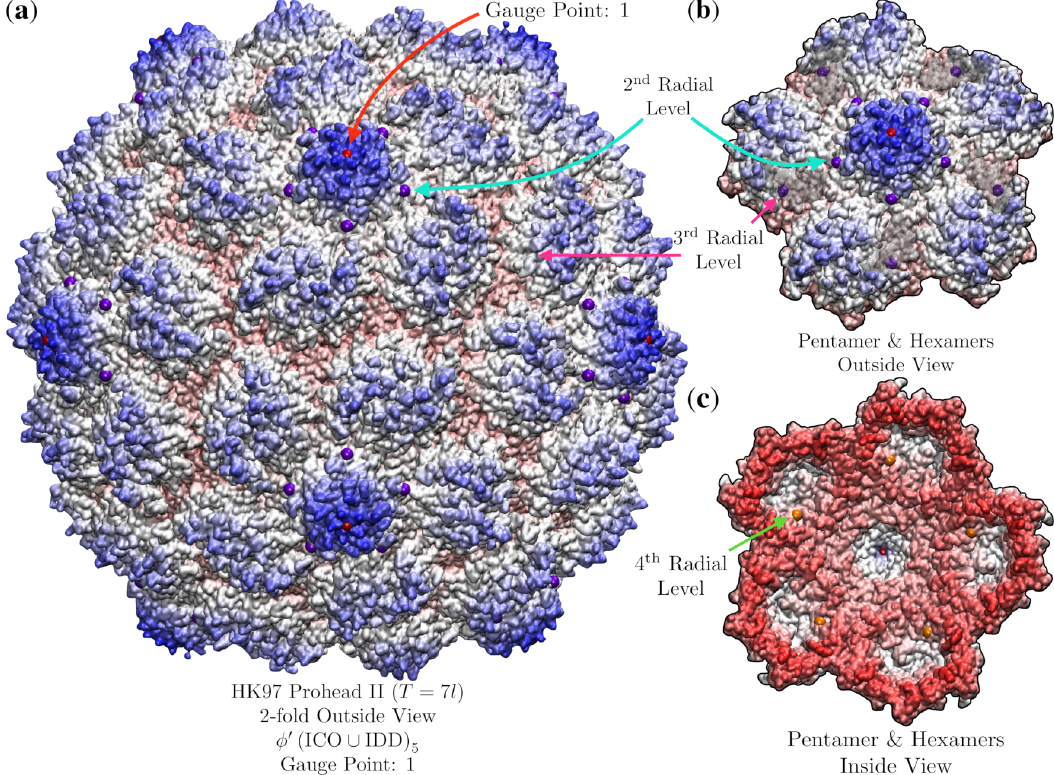
Figure 20. Point arrays may predict a loss of local symmetry of hexameric subunits for Bacteriophage HK97 Prohead II ( T = 7 l , 3e8k [37]), as the hexamer subunits have different geometric restrictions at non-equivalent locations. ( a ) This capsid is best fitted by φ (cid:48) ( ICO ∪ IDD ) 5 with an RMSD of 1.8 Å. The pentamer protrudes at Gauge Point 1, as do many T = 7 viruses, and then the surface bows inward to fit beneath the 2nd radial level (purple). ( b ) There are small pockets within the hexamers, where the 3rd radial level along the 5-3 GC sits just below the surface of the hexamer (purple), the atoms above the pocket have been made translucent. ( c ) Inside view, each hexamer is bounded on the inside by the 4th radial level along the 5-3 GC point (orange). The pentamers and hexamers are each bounded by two different points within the